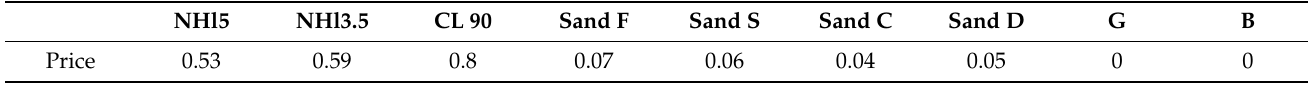
Table 8. Cost ( € /kg) of raw